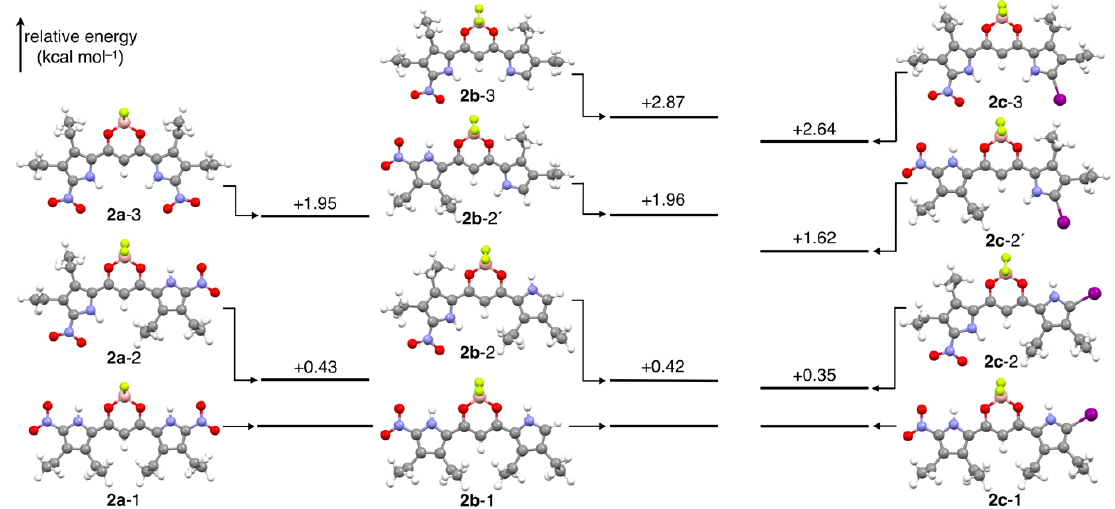
Figure 5. Energy diagram of diverse conformations of 2a ( left ), 2b ( middle ), and 2c ( right ) calculated at the B3LYP level by using the 6-31G(d,p) basis set for C, H, B, N, O, and F and the LanL2DZ basis set for I. The relative energies (kcal/mol) are shown, and the energy standards are set to the most stable conformations of respective derivatives ( 2a -1, 2b -1, and 2c -1).